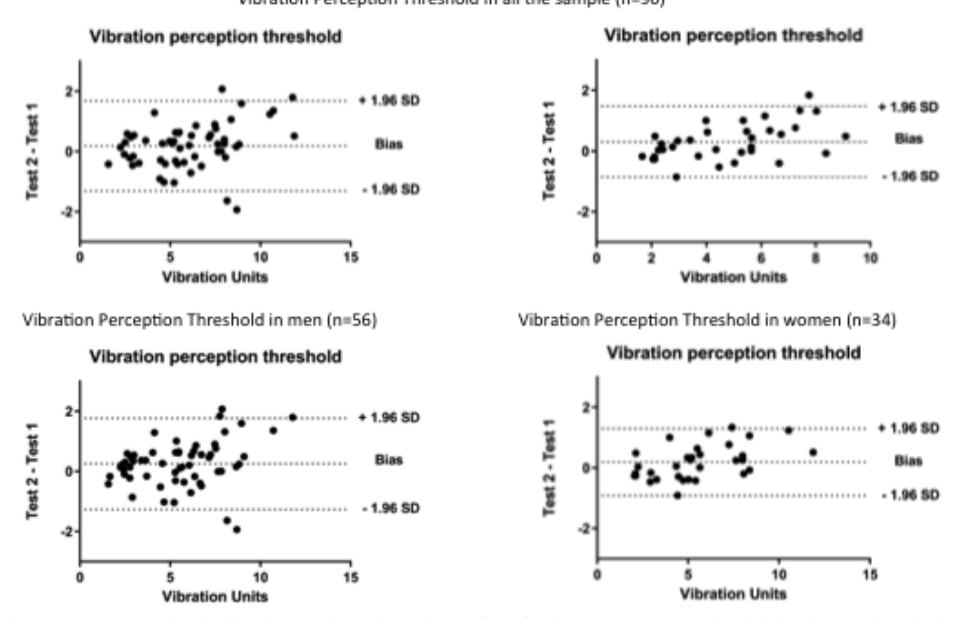
Figure 1. The Bland–Altman graphs of all groups analyzed in the study.